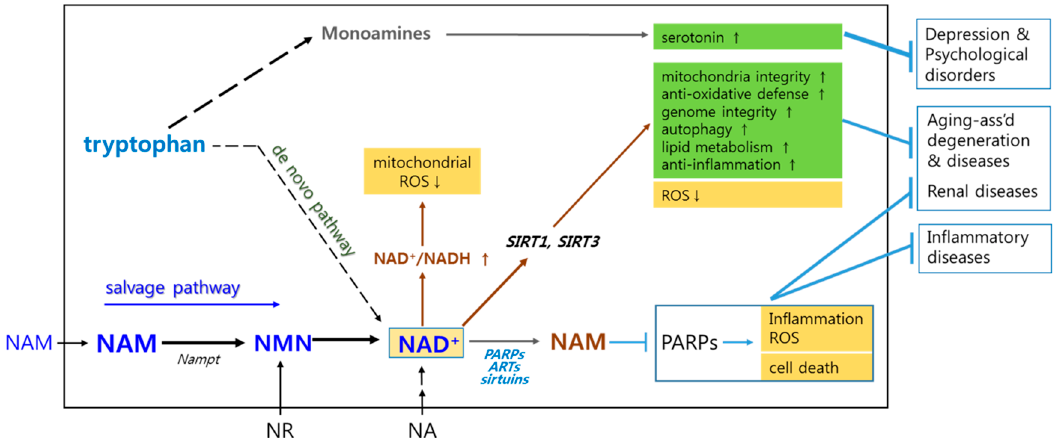
Figure 1. A schematic representation of routes of metabolism and beneficiary effects of NAM. In cells (grey-lined box), NAM is converted to nicotinamide adenine dinucleotide (NAD + ) mainly through salvage pathways via nicotinamide mononucleotide (NMN). NAD + is reduced to become NADH and thereby, establishes NAD + redox, through which NAM treatment affects mitochondrial energetics and ROS generation. NAD + is also broken down to NAM and ADP-ribose by poly(ADP-ribose) polymerases (PARPs), sirtuins, and a family of ADP-ribose transferases (ARTs), to which NAM exerts feedback inhibition. Among these, inhibition of PARPs constitutes an important route of anti-inflammatory, anti-oxidative, and pro-cell survival effects. Increased level of NAD + activates sirtuin proteins such as SIRT1 and SIRT3, which exert a variety of cell-beneficiary effects such as anti-oxidation, genome stability, autophagy, and lipid metabolism. In addition, they together maintain mitochondria quality and integrity, and thereby, keep reactive oxygen species (ROS) generation at low level. Through these, NAM may exert effects against aging-associated degeneration and diseases, and renal and inflammatory diseases. Through these effects, NAM may help protecting neurons and pancreatic β -cells. Meanwhile, a minor portion of cellular NAD + pool is provided through de novo synthesis from tryptophan, which is also a source for serotonin. Therefore, NAM supplement helps maintaining serotonin level, and thereby alleviates depression and psychological disorders. NAD +